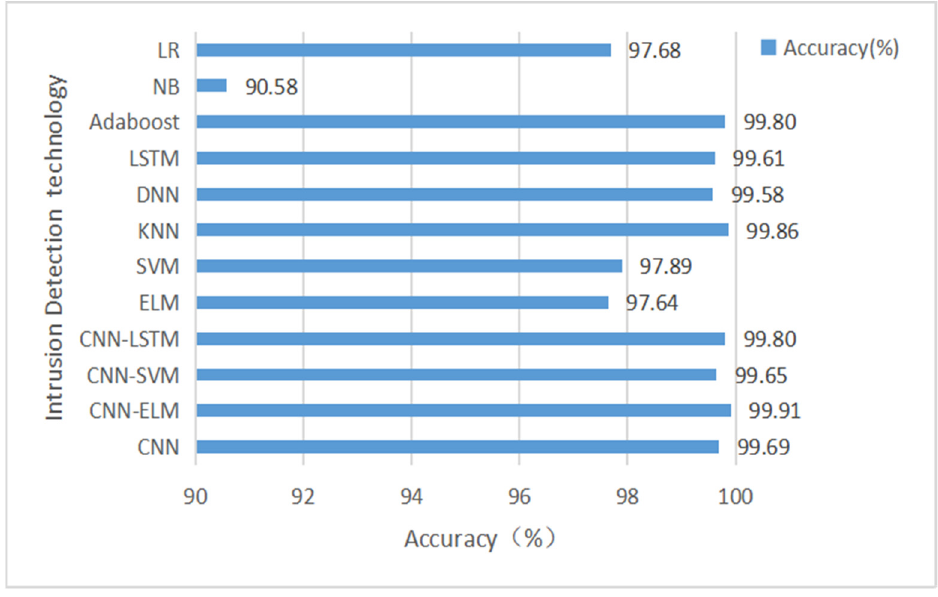
Figure 9. The accuracy comparison of CNN-ELM hybrid models based on the results of 12 subsets of features in the InSDN dataset.